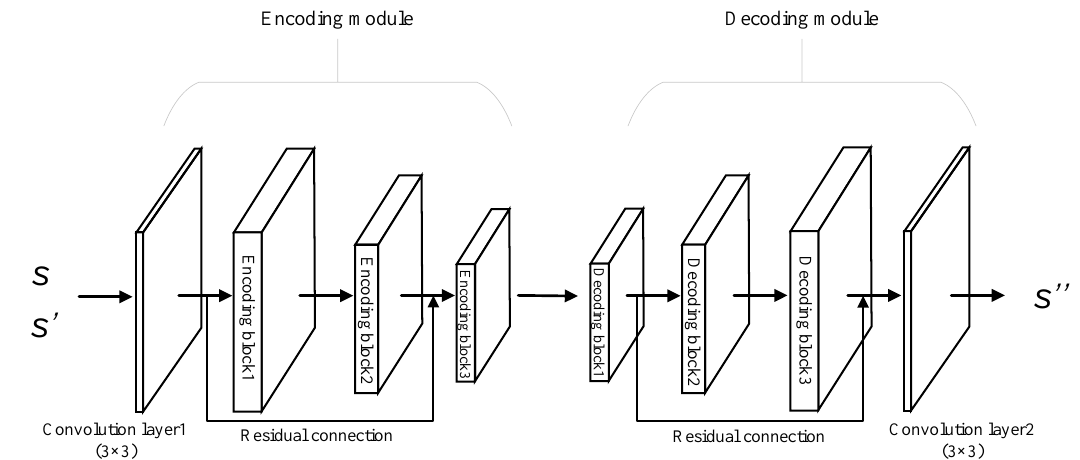
Figure 2. Dual residual denoising autoencoder network framework with channel attention.